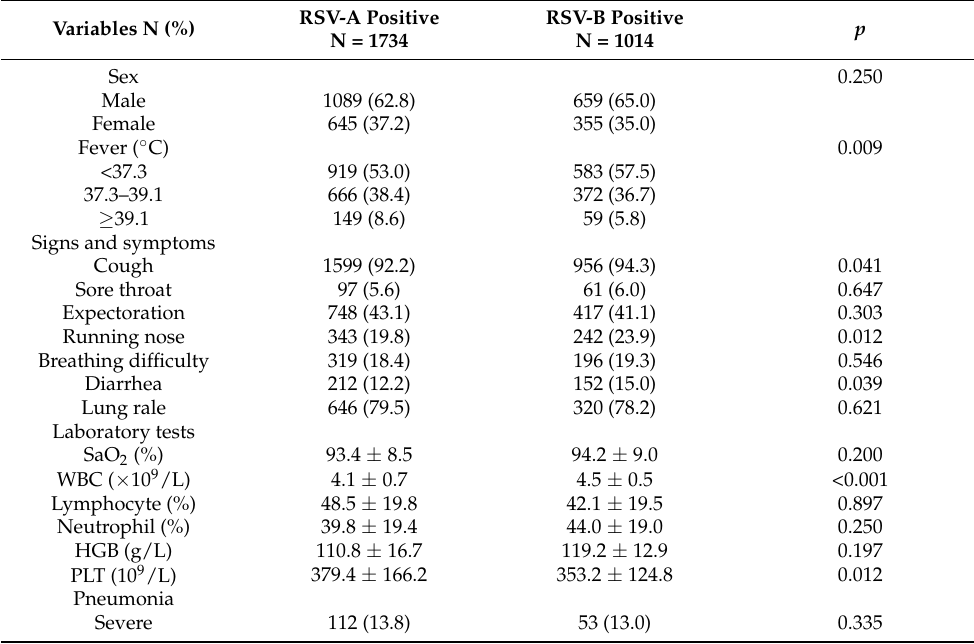
Table 3. Clinical characteristics of RSV-A positive and RSV-B positive